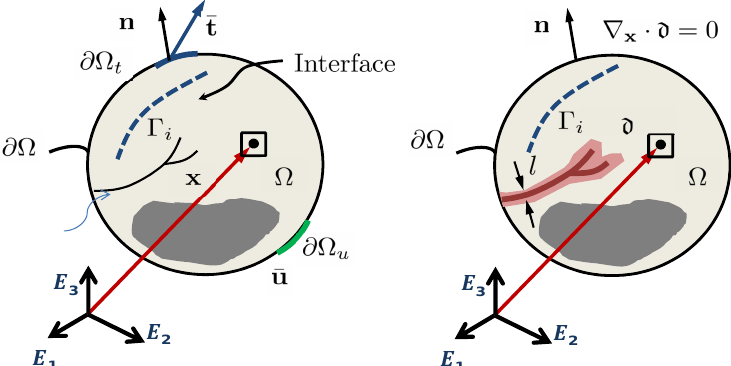
Figure 8. Coexistence between brittle fracture in the bulk and cohesive debonding of an interface within the context of the phase field approach of